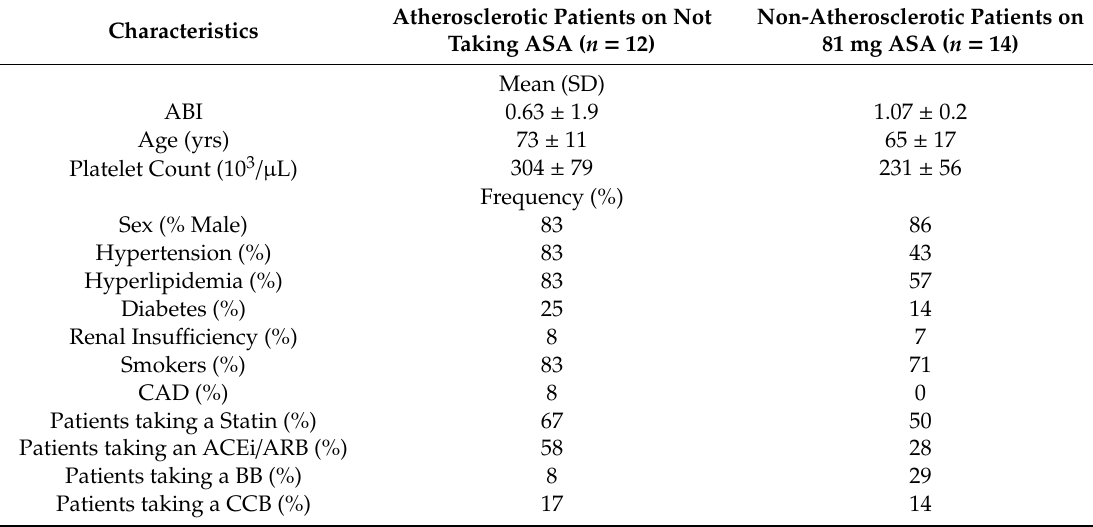
Table A1. Baseline characteristics of patients not taking 81 mg ASA with documented atherosclerotic disease and patients taking 81 mg ASA with no documented atherosclerotic disease. Atherosclerotic Patients on Not Non-Atherosclerotic Patients on Characteristics Taking ASA ( n = 12) 81 mg ASA ( n =